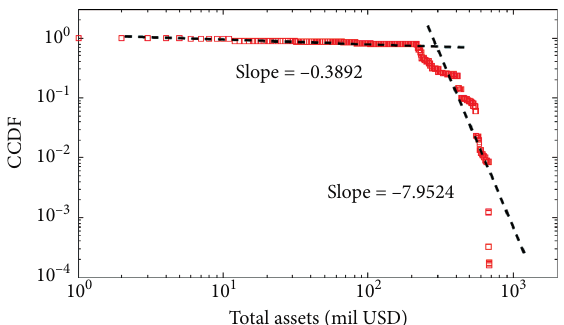
Figure 3: A log-log complementary cumulative distribution function (CCDF) of assets (weights), according to dataset of interbank markets of EU15 in 2018.